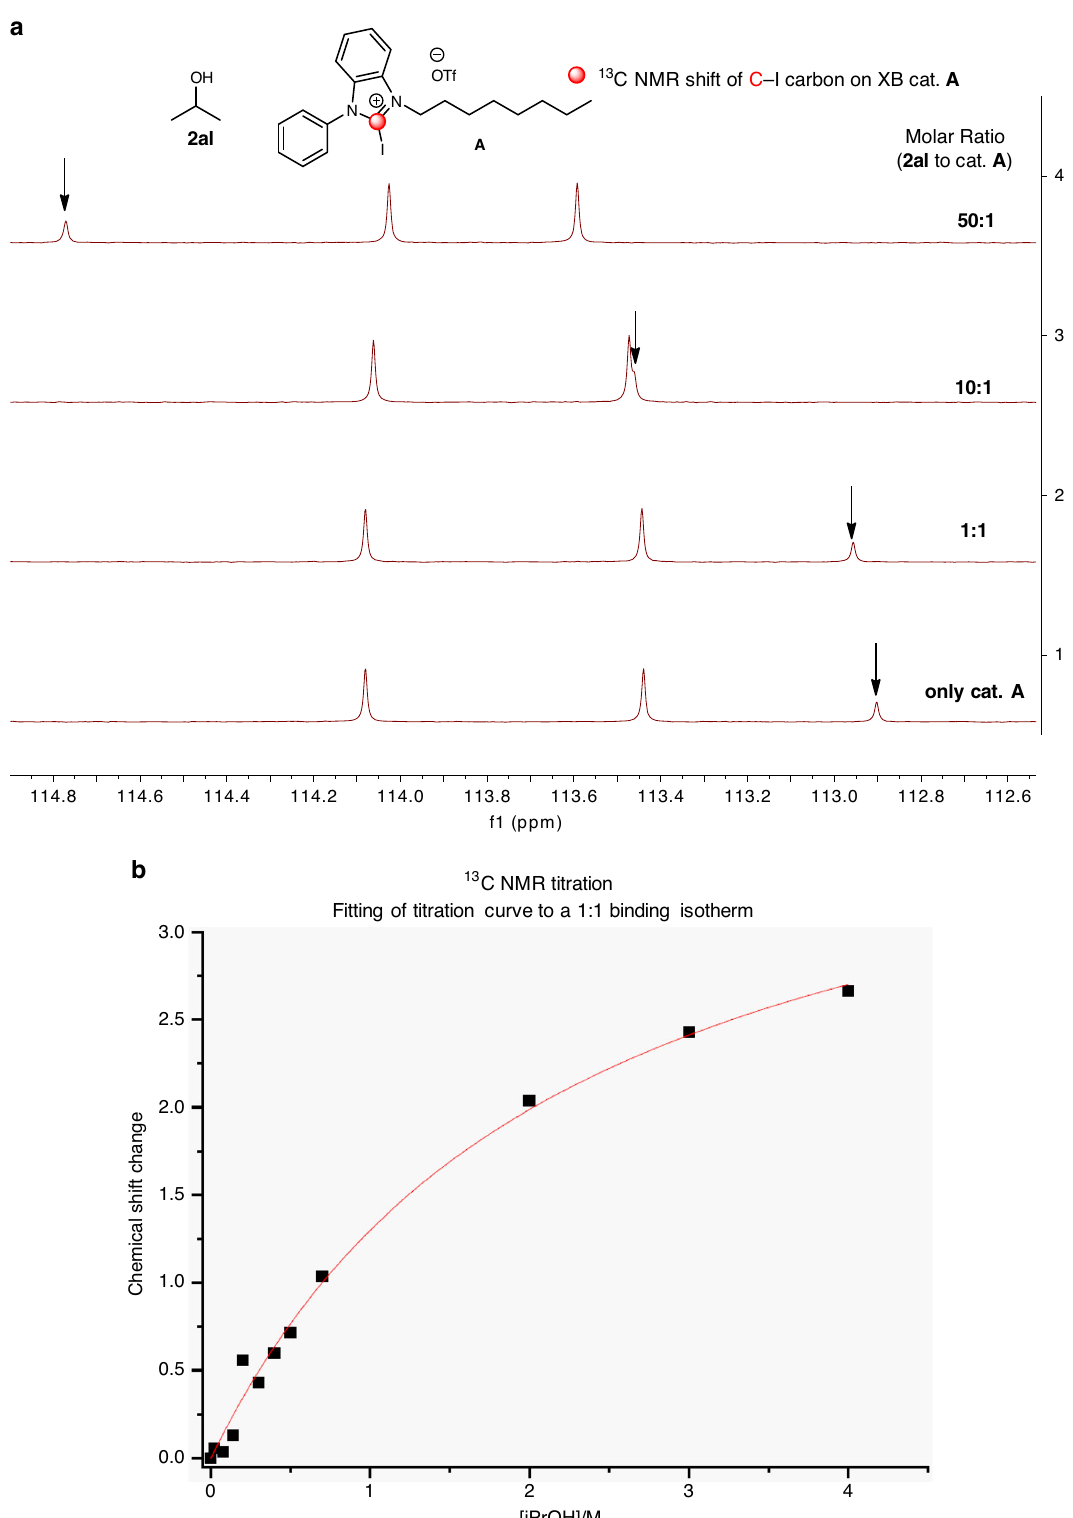
Fig. 4 NMR titrations and isothermal titration calorimetry to ascertain XB activation. a 13 C NMR titration ( 13 C resonance of C – I bond denoted in arrows). b Fit of the 13 C NMR titration to a 1:1 binding